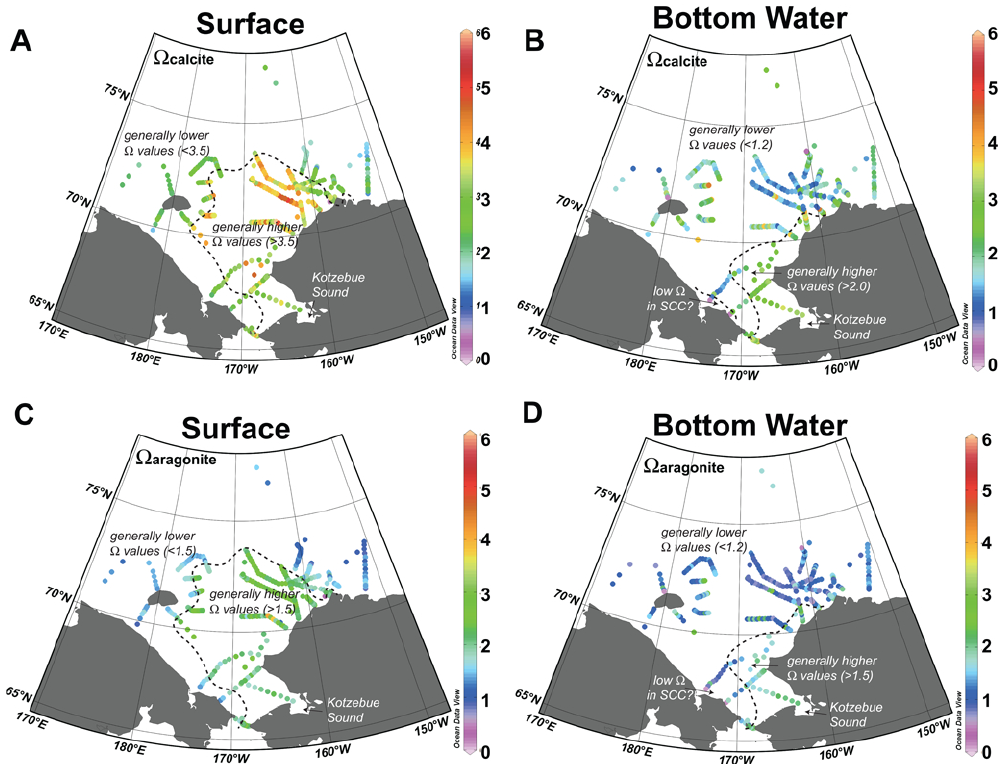
Fig. 5. Composite (2009–2011) summertime maps of surface and bottom-water (cid:127) calcite and (cid:127) aragonite in the western Arctic Ocean (primarily Chukchi Sea but also eastern East Siberian Sea and western Beaufort Sea). The panels include (A) surface (cid:127) calcite ; (B) bottom-water (cid:127) calcite ; (C) surface (cid:127) aragonite ; and (D) bottom-water (cid:127) aragonite